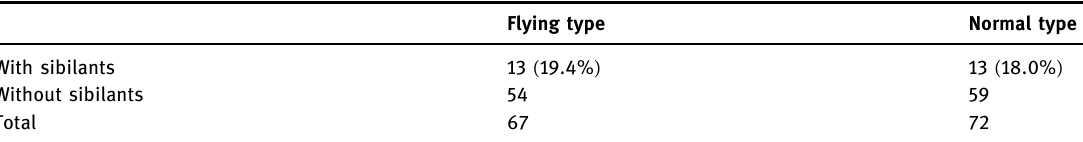
Table 3: The numbers of names that contain sibilants and those that do not in the fl ying - type and normal - type